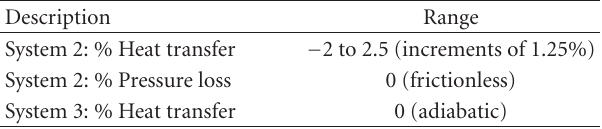
Table 3: Description of test cases for 1 Degree of Freedom (DOF) and 5